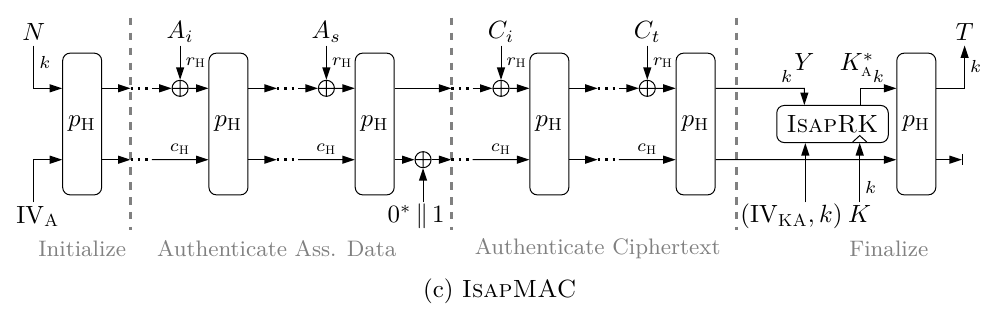
Figure 1: Isap authenticated